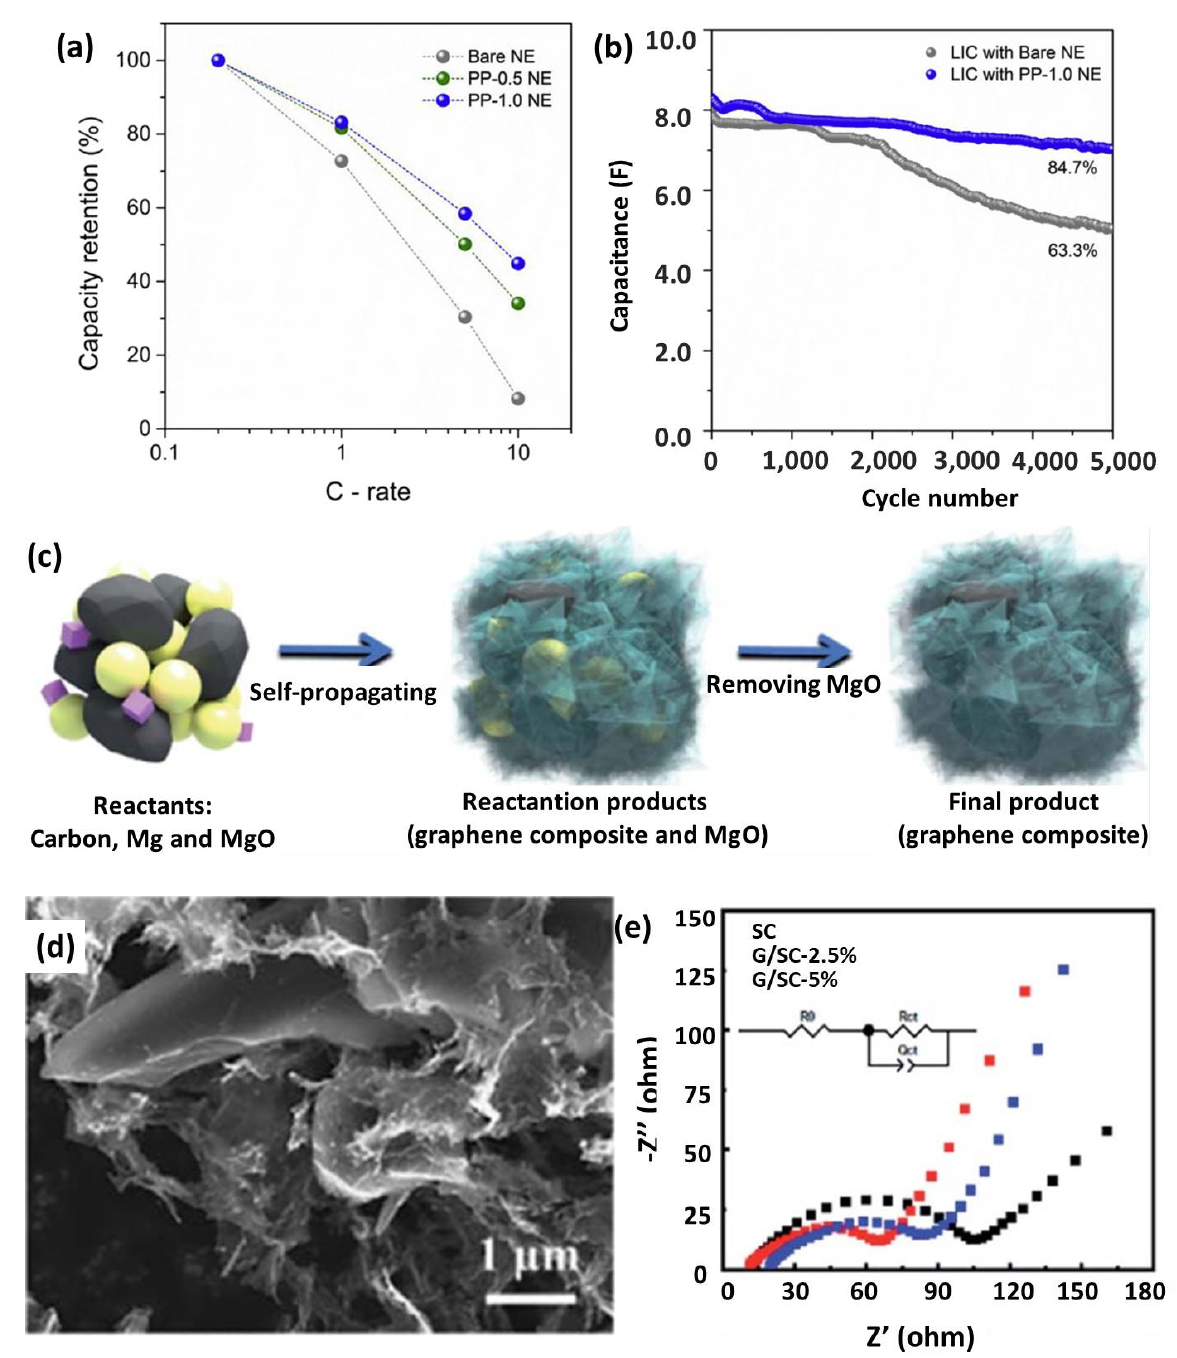
Figure 8. ( a ) Capacity retentions at various current densities during charge; ( b ) Capacitance retention of LICs employing bare NE and PP-1.0 NE. Reproduced with permission from Ref. [173]. Copyright 2015, Elsevier. ( c ) Schematic diagram of preparing G/SC; ( d ) SEM image of the G/SC composite; ( e ) EIS curves of pure SC and G/SC. Reproduced with permission from Ref. [78]. Copyright 2021, Royal Society of Chemistry.